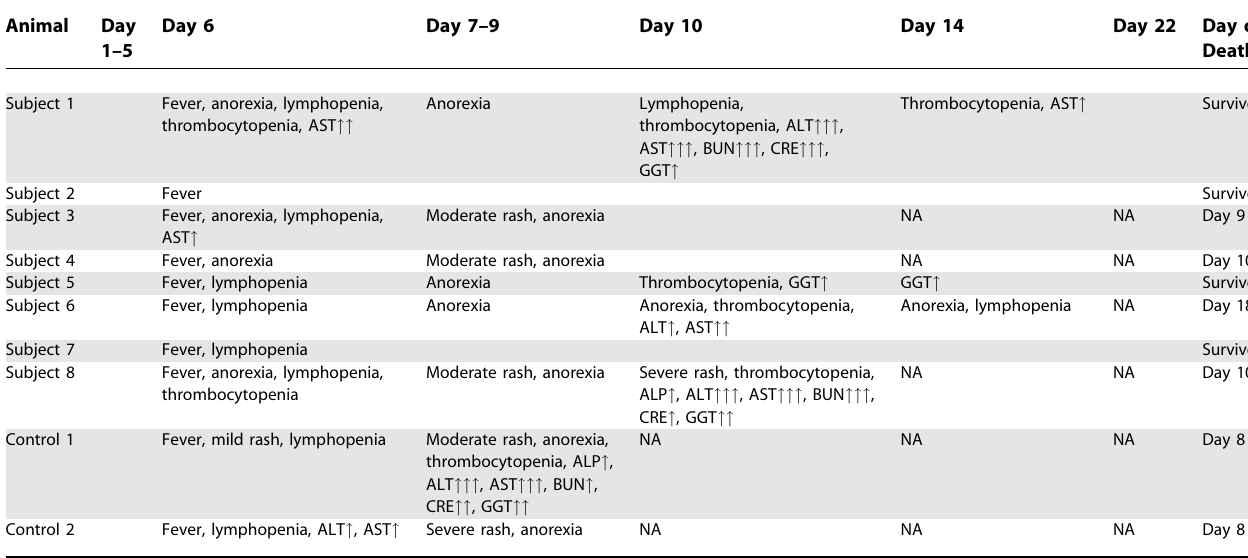
Table 1. Clinical Findings